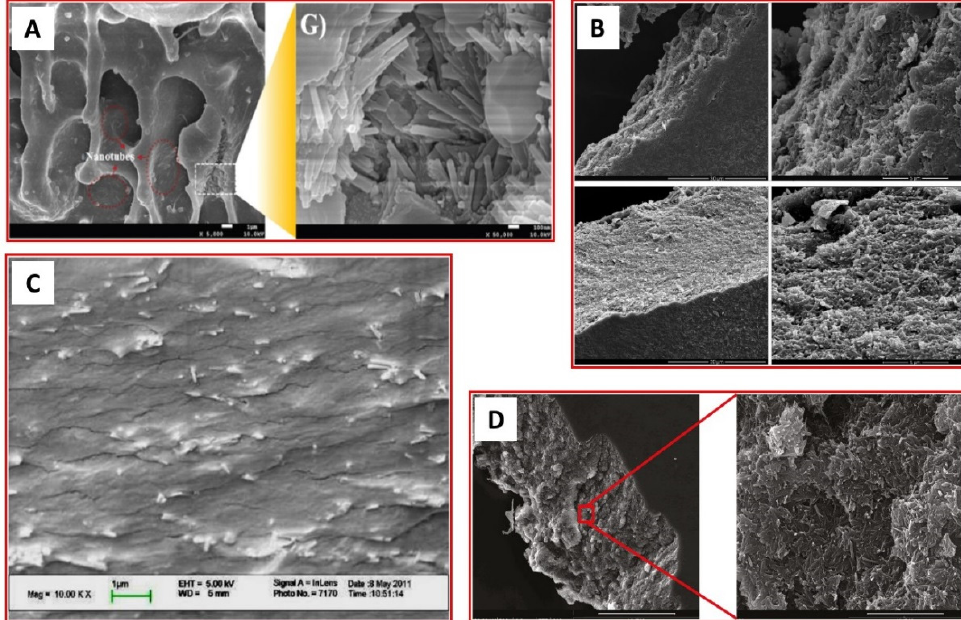
Figure 3. SEM images of the cross-section of various biopolymer/HNT films: ( A ) HNTs-EP combined with sodium alginate. Reproduced with permission from Ref. [103]. Copyright 2018 Royal Society of Chemistry, ( B ) HNTs combined with HM pectin (top) and LM pectin (bottom) Reprinted with permission from Ref. [127]. Copyright 2011 American Chemical Society, ( C ) HNTs combined with chitosan. Reproduced with permission from Ref. [121]. Copyright 2012 Elsevier, ( D ) HNTs combined with hydroxypropyl cellulose. Reprinted with permission from Ref. [125]. Copyright 2011 American Chemical Society.